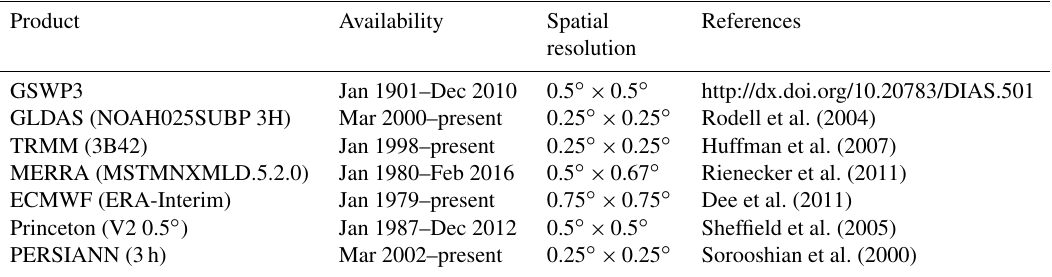
Table 1. Precipitation data from seven different products used in this study, the Global Soil Wetness Project Phase 3 (GSWP3), the Global Land Data Assimilation System (GLDAS), the Tropical Rainfall Measuring Mission (TRMM), the Modern-Era Retrospective Analysis for Research and Applications (MERRA), the European Centre for Medium-Range Weather Forecasts (ECMWF), Princeton’s Global Mete- orological Forcing Dataset (Princeton), and the Precipitation Estimation from Remotely Sensed Information using Artificial Neural Net- works (PERSIANN). The temporal resolution of all products is 3h. Most products are available to present while GSWP3, MERRA, and Princeton terminate earlier.